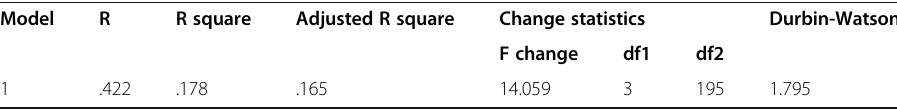
Table 3 Model summary